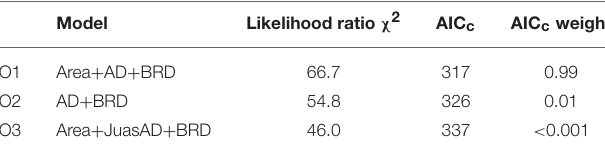
FIGURE 3 | Relationships between Ashe juniper crown death rate and significant risk factors in the top regression model (J1). The values of the risk factors were divided into classes of individual basal stem area (A) , the basal stem area density of Ashe juniper (B) , the basal stem area of Texas persimmon (C) and elevation (D) . Data were binned into 10 (Area, JuasAD. Elev) or 7 (DiteAD) classes with approximately equal membership and the class average was plotted on the x-axis. The smaller number of bins were dictated by the granularity of the data. See Table 2 for an explanation of variable names. TABLE 4 | The three top regression models for incidence of crown death in live